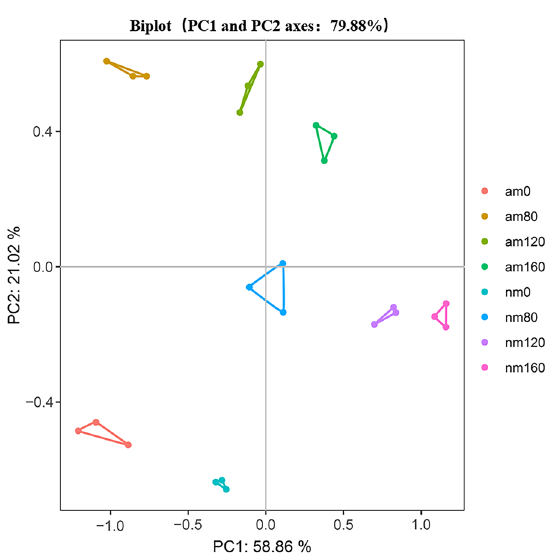
Fig. 7 Principal component analysis (PCA) in Oryza sativa L. under salt and AMF compound inoculant treatments. Note: nm: non-mycorrhizal; am: Fm Pi Ar.0: 0 mM NaCl; 80: 80 mM NaCl; 120: + + 120 mM NaCl; 160: 160 mM